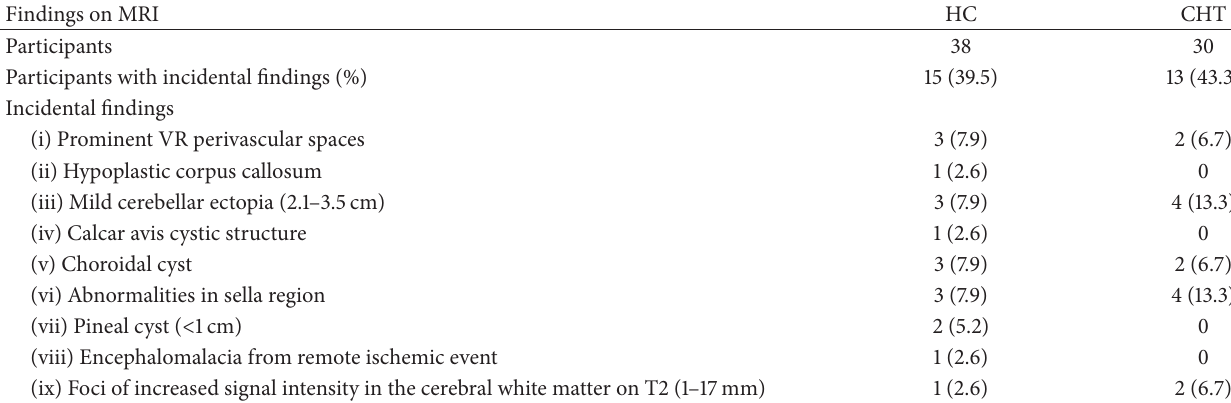
Table 1: Distribution of abnormal findings detected on MRI according to study group.